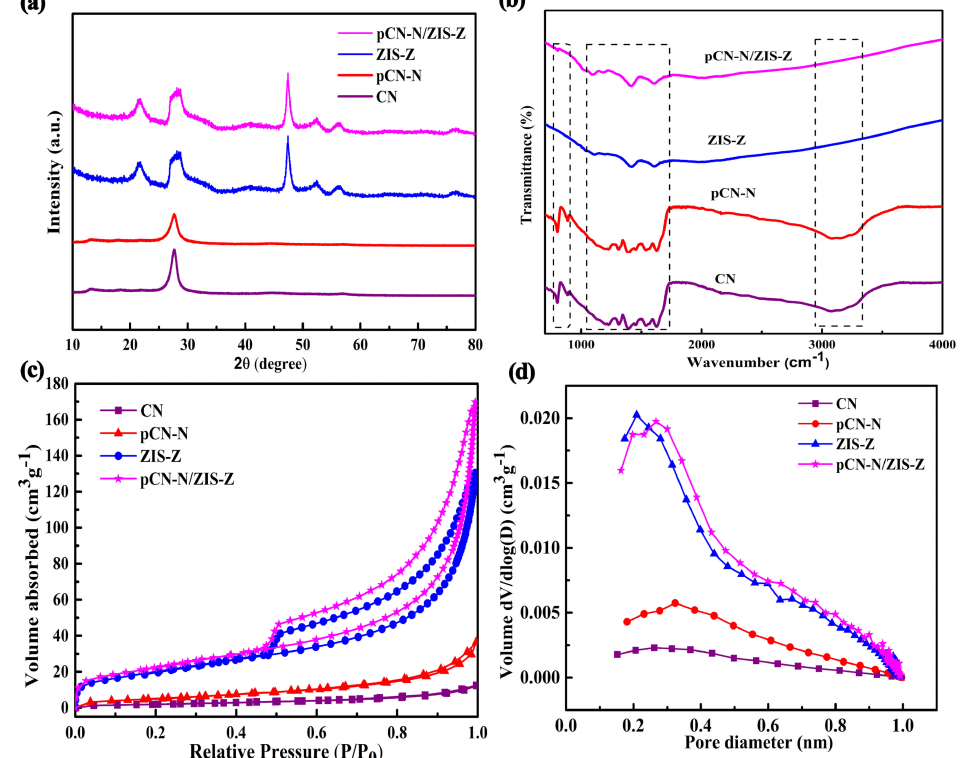
Figure 4. XRD patterns ( a ), FTIR spectra ( b ), surface area ( c ), and pore size distribution ( d ) of CN, pCN-N, ZIS-Z, and pCN-N/ZIS-Z